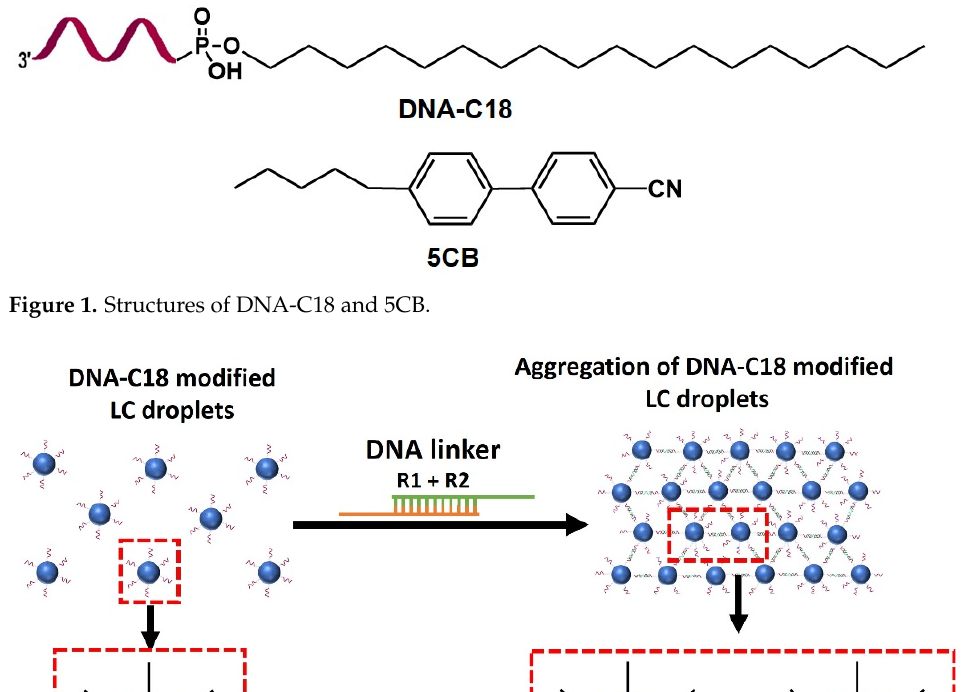
Figure 2. Schematic diagram of DNA ‐ modified LC droplets and aggregated DNA ‐ modified LC droplets in presence of DNA linker R1 + R2. Microscope images of DNA ‐ modified LC droplets be ‐ fore ( a – c ) and after ( d – f ) adding DNA linker; ( a , d ) bright field, ( b , e ) polarized light, ( c , f ) photograph of macroscopic emulsion.